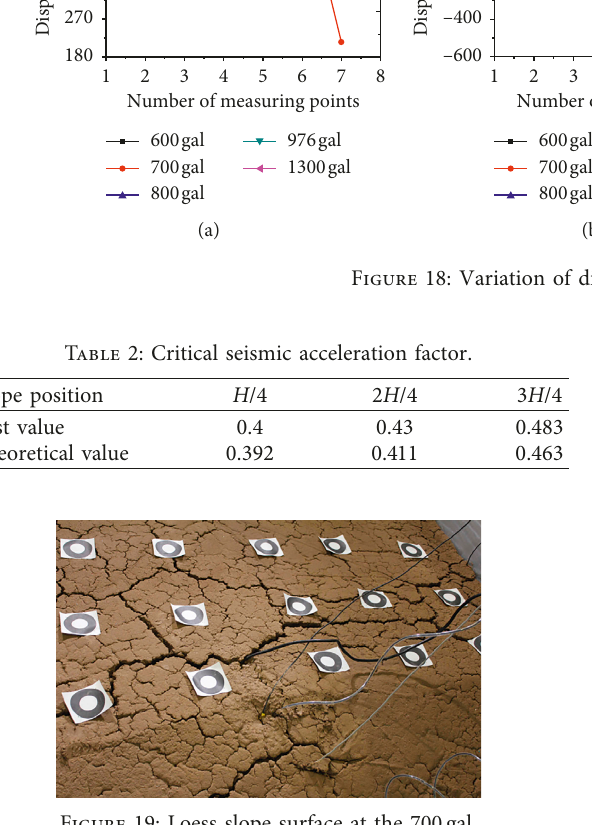
Figure 19: Loess slope surface at the 700gal.